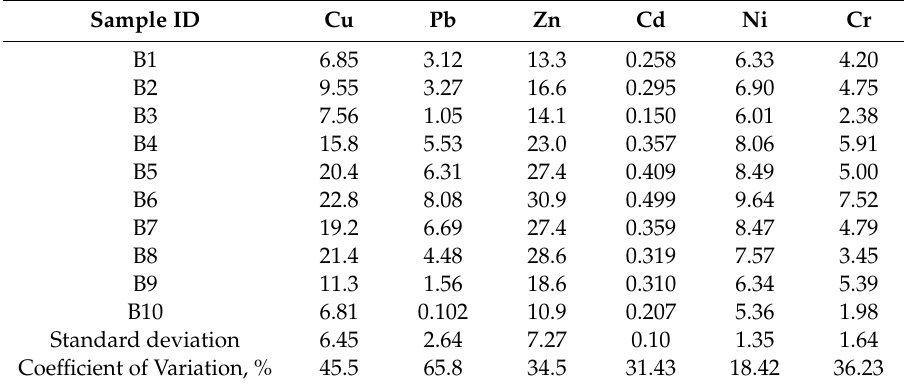
Table 2. The content of trace metals from the studied cryoconites (mg · kg − 1